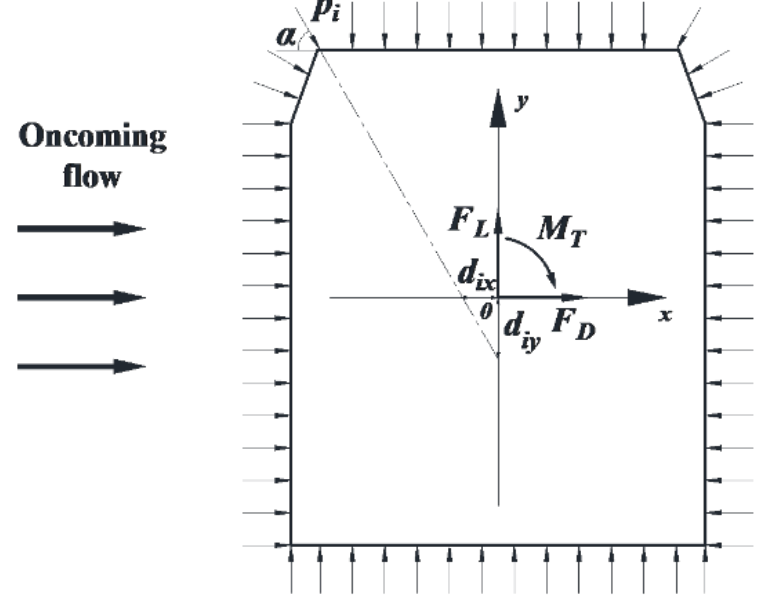
Figure 6. Sketch of the aerodynamic force in the body axis system.